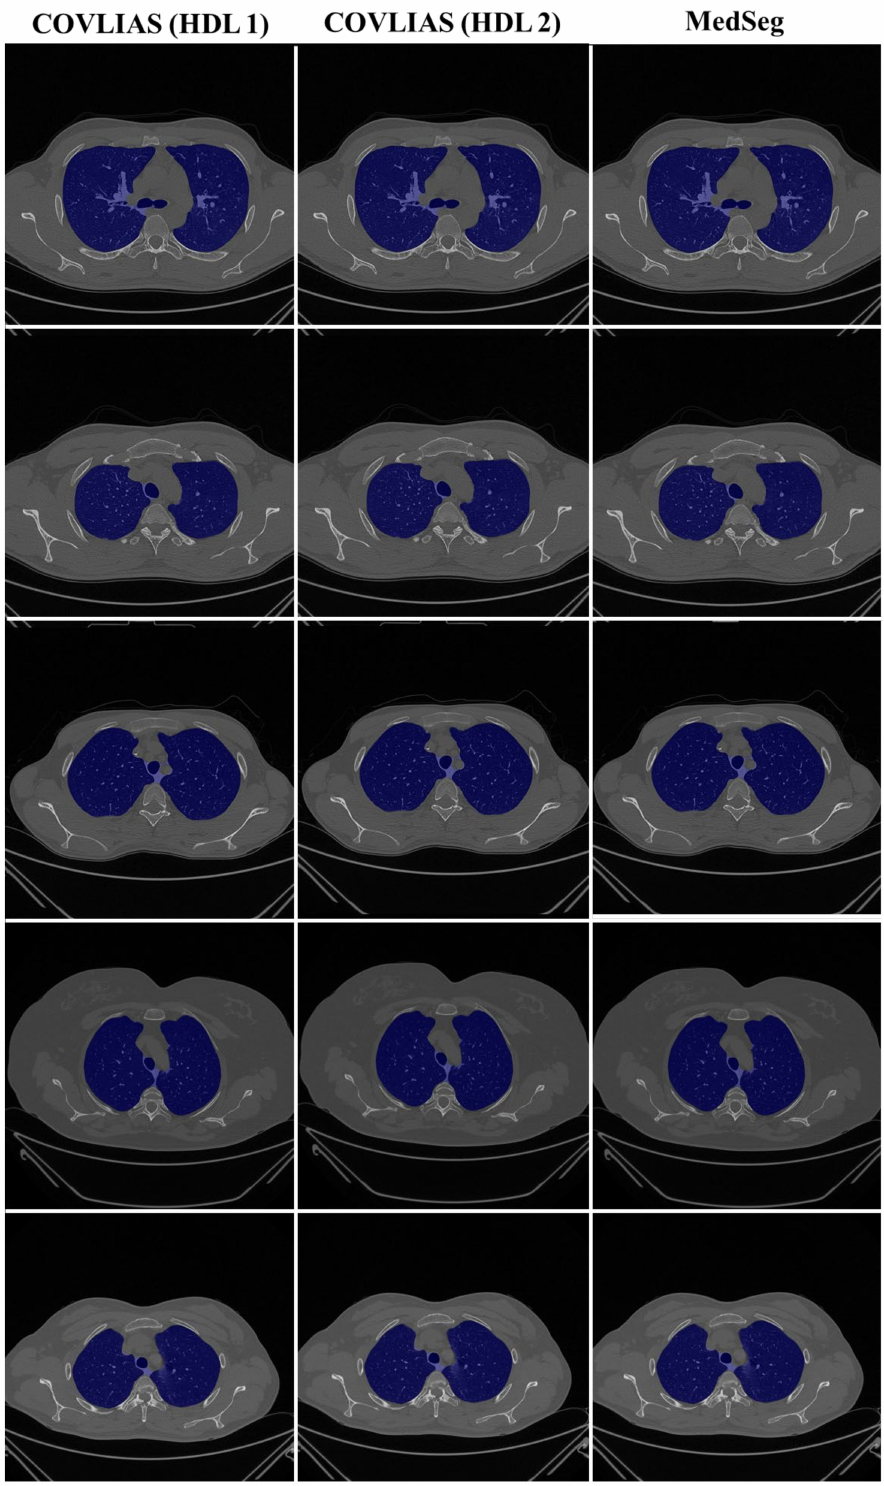
Figure 22. COVLIAS vs. MedSeg: Segmented mask (blue) on the Control CT lung image (small